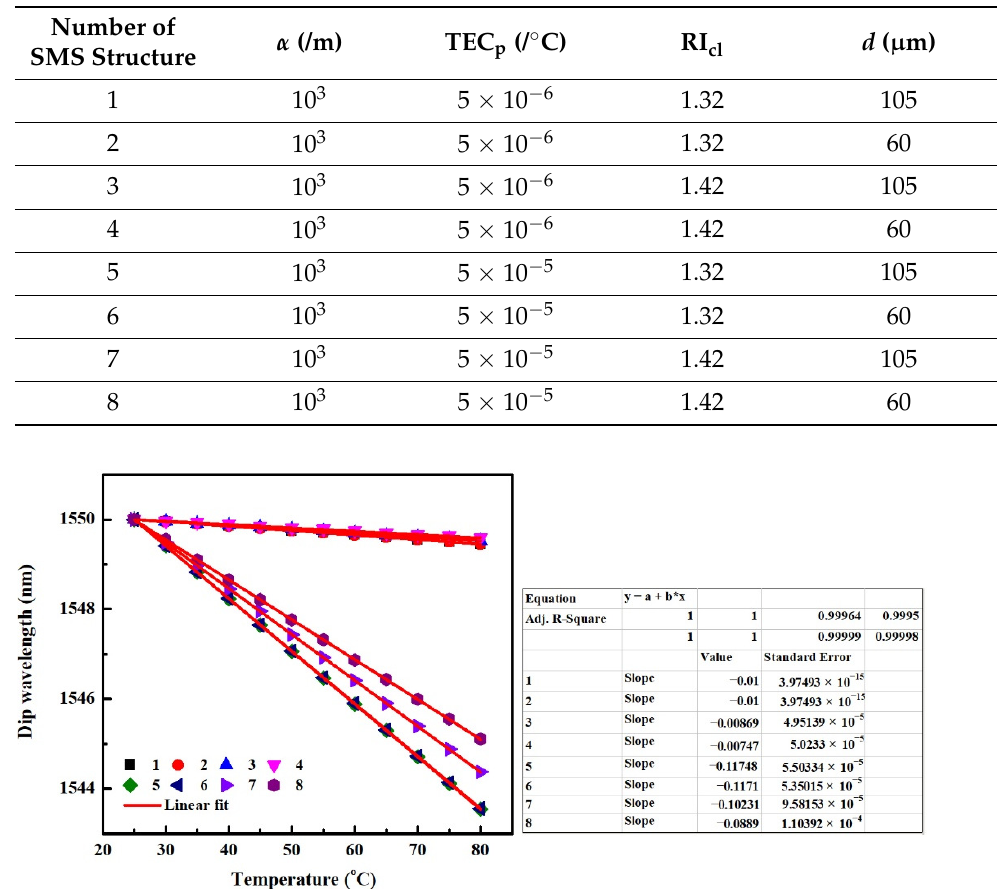
Table 3. Parameters of MMF and packaging shell in the SMS fiber structure.